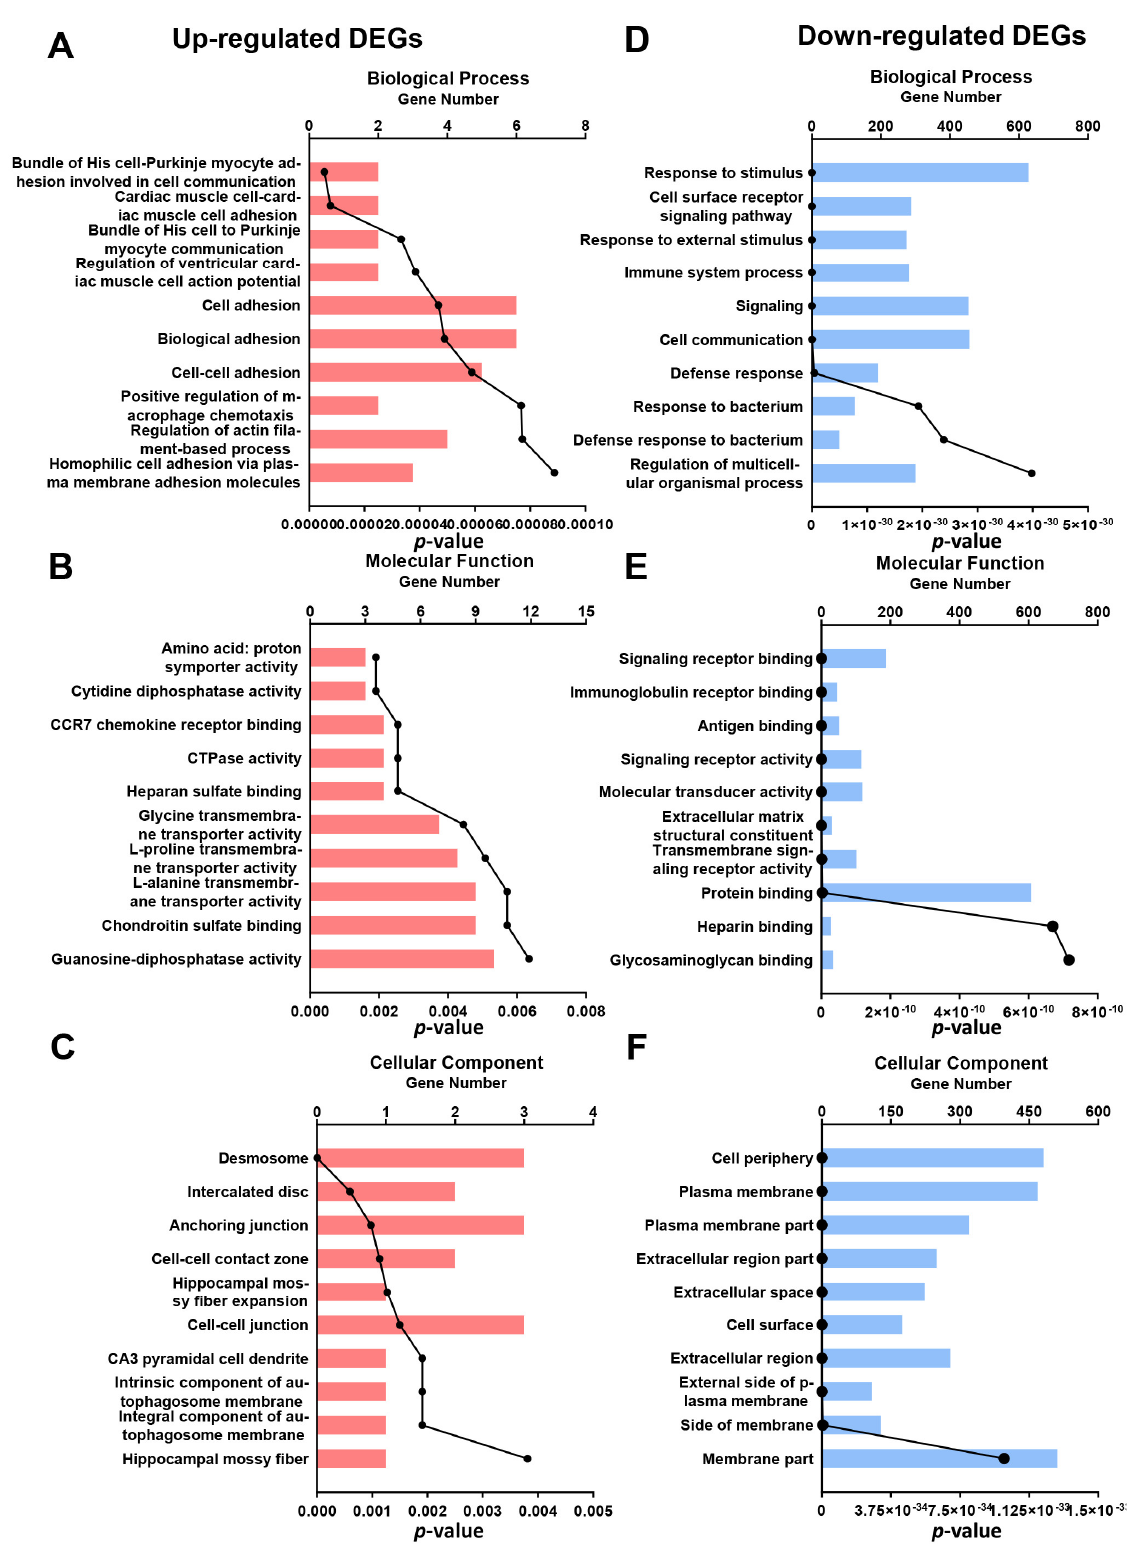
Figure 5. GO analysis of DEGs in TDCPP vs. control. The top 10 most significant p -values for the GO terms were upregulated by TDCPP compared to controls in terms of biological processes (BP) ( A ), molecular functions (MF) ( B ), and cellular components (CC) ( C ). The top 10 most significant p - values for the GO terms were downregulated by TDCPP compared to controls in terms of biological processes (BP) ( D ), molecular functions (MF) ( E ) and cellular components (CC) ( F ).